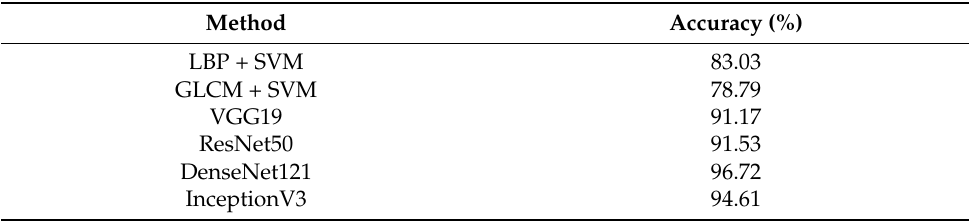
Table 3. Comparison of other classification